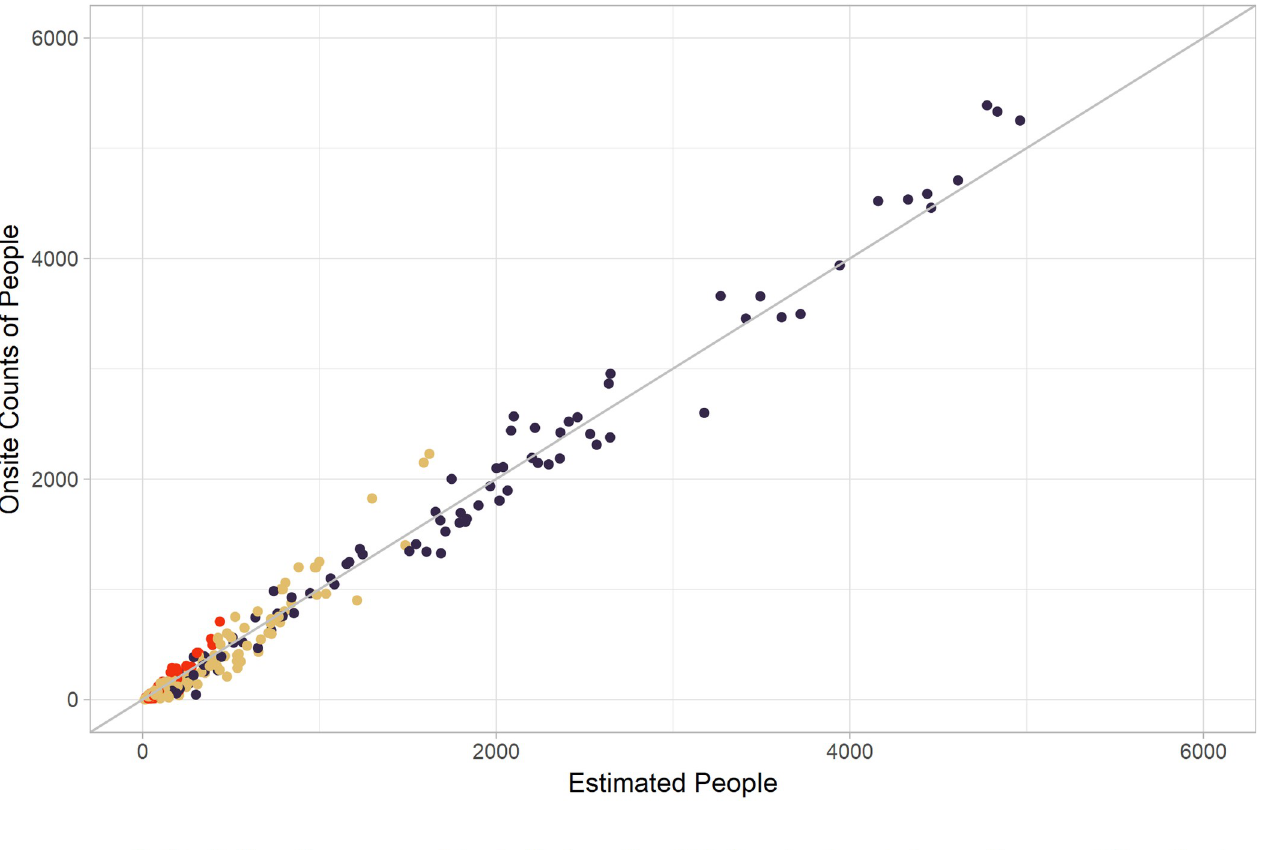
Fig 3. Cell data modeled visitation compared against observations. Predicted daily (9AM-4PM) visits from the cell data model compared to observed visitation at three sizes of water recreation areas in New England, USA.